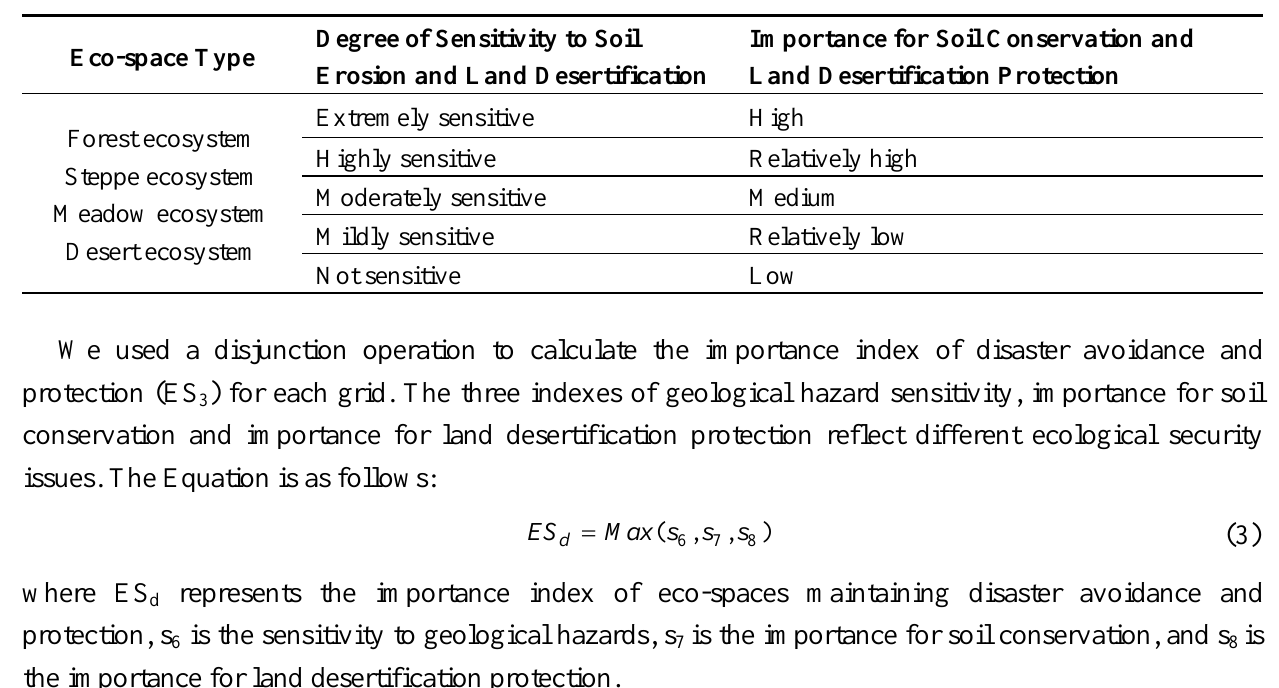
Table 3. Importance rankings for soil conservation and land desertification